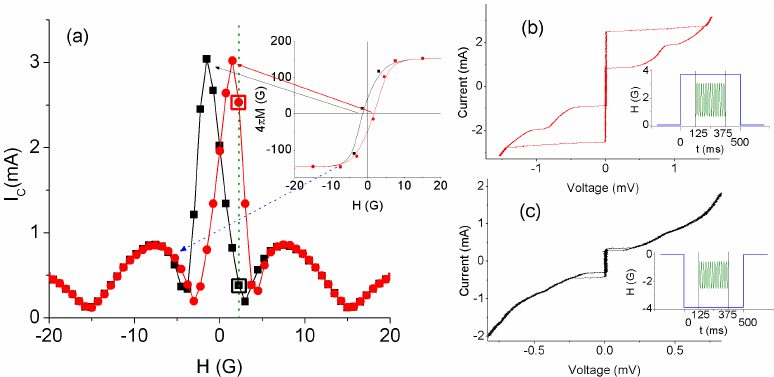
Figure 1. ( a ) I C ( H ) at 3.5 K. Black squares correspond to an external magnetic field ramped from positive to negative values, red circles are obtained ramping the field from negative to positive values. Lines are plotted as a guide for the eye. Green dotted line represents the chosen working point. Inset: magnetization curve for the same sample, obtained using the technique described in [8]. Red and black arrows indicate the positive and negative coercive field H C on the two curves. Blue arrow indicates the saturation field H S on both curves. ( b , c ) I ( V ) curves corresponding to the points highlighted by green dotted line in panel (a), which are the two critical current levels used as logical states. The insets show the combination of magnetic field pulses and RF trains used to induce the switch between the two